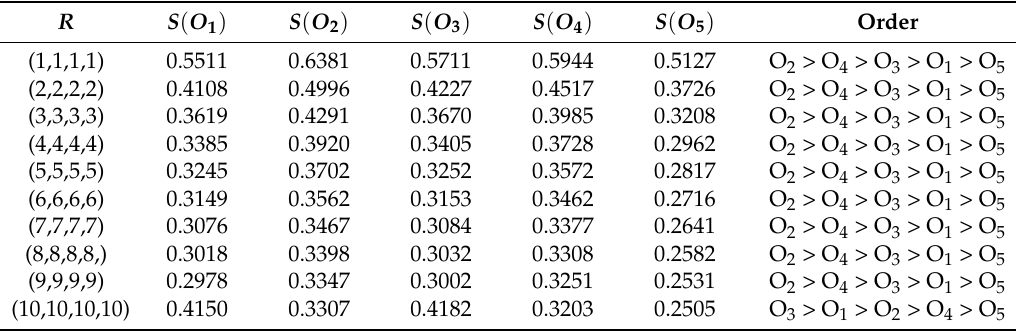
Table 5. Order for different parameters of